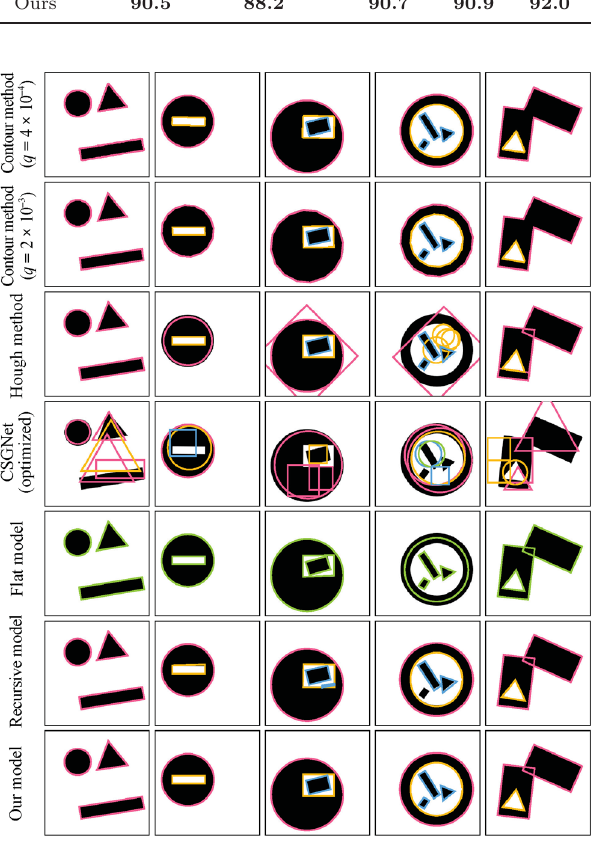
Fig. 5 Detection results examples. Shapes detected at different levels are marked in different colors: level 1, pink; level 2, orange; level 3, blue. For the flat model, there is no predicted layer information, so all shapes are marked in green.